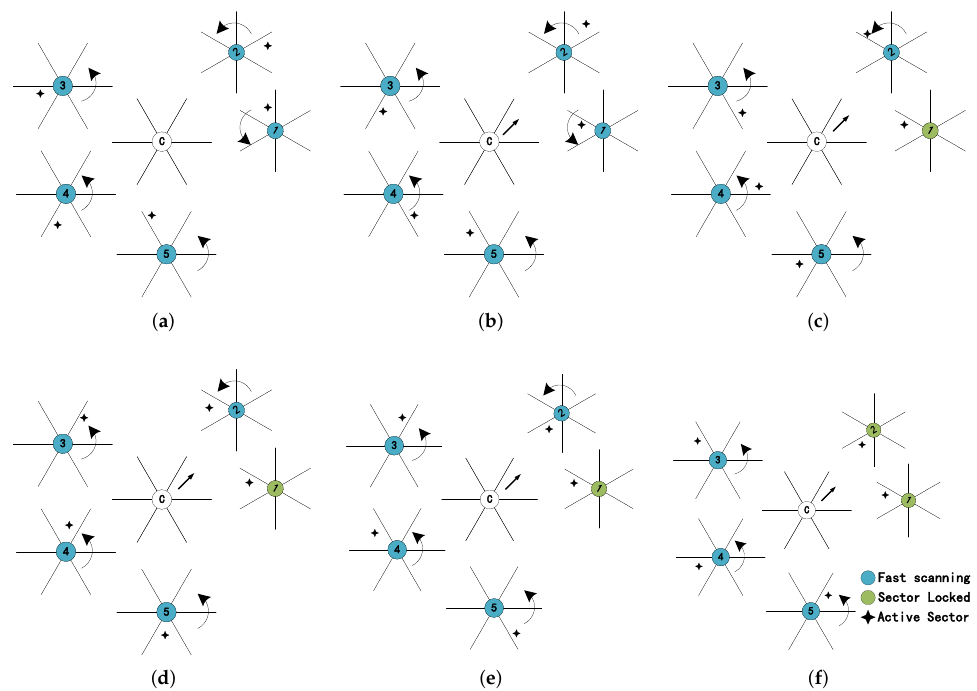
Figure 7. An example of beacon dispatch. ( a ) All cluster members are in fast scan mode. ( b ) The cluster head starts to send beacon frames in the first sector. ( c ) Cluster member 1 has locked the sector. ( d ) The cluster head sends beacon frames continuously until cluster member 2 switches to the sector pointing to the cluster head. ( e ) Cluster member 2 has pointed at the cluster head. ( f ) Cluster member 2 has locked the